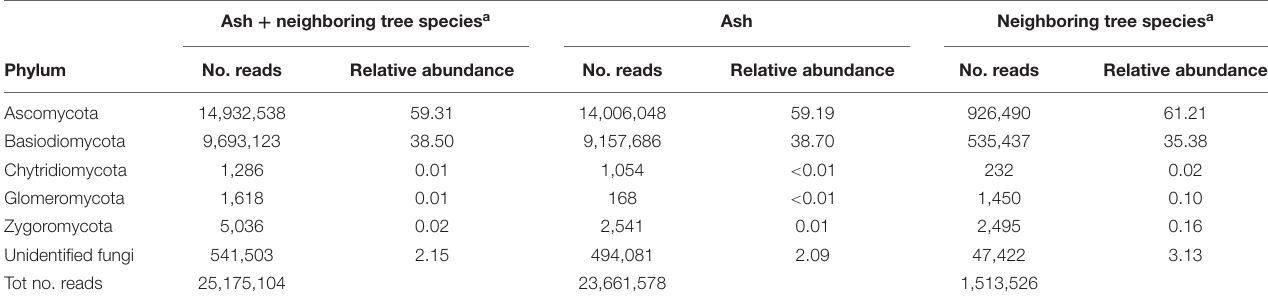
TABLE 2 | Number of reads and relative abundance of reads for all samples, only ash trees, and neighboring tree per fungal